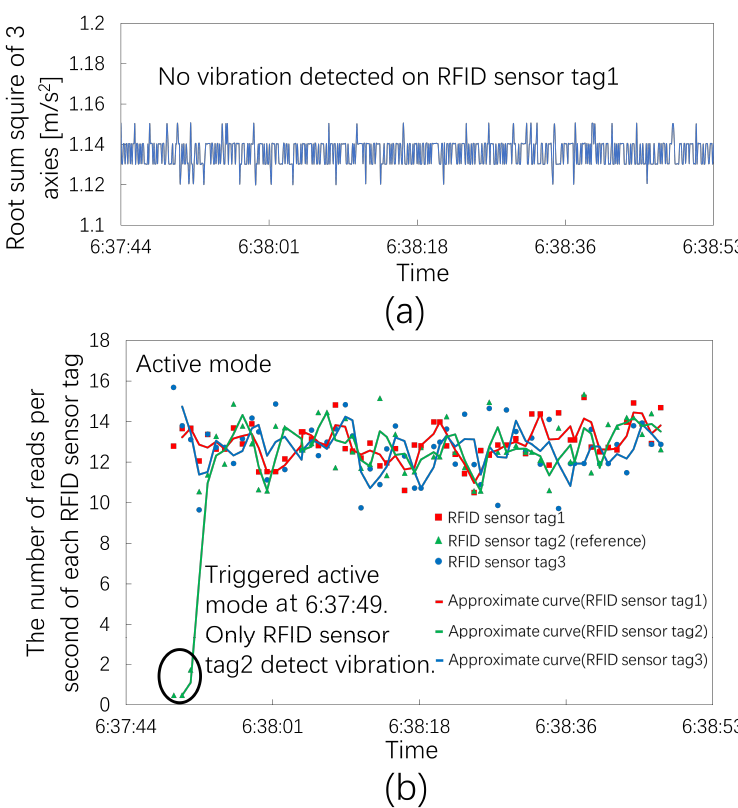
Figure 14. The number of reads per second of three RFID sensor tags at an earthquake seismic intensity of 1. ( a ) The root sum square of the accelerated sensor system and no vibration detected on RFID sensor tag 1. ( b ) The number of reads per second of each RFID sensor tag in that experiment. Figure 15a shows the observed results for the earthquake on 14 November 2022, at 17:09 JST. The epicenter region was on the southeast coast of Mie Prefecture, and the epicenter was 421 km away from Hitachi. The seismic magnitude scale was 6.1. The seismic intensity in Hitachi was